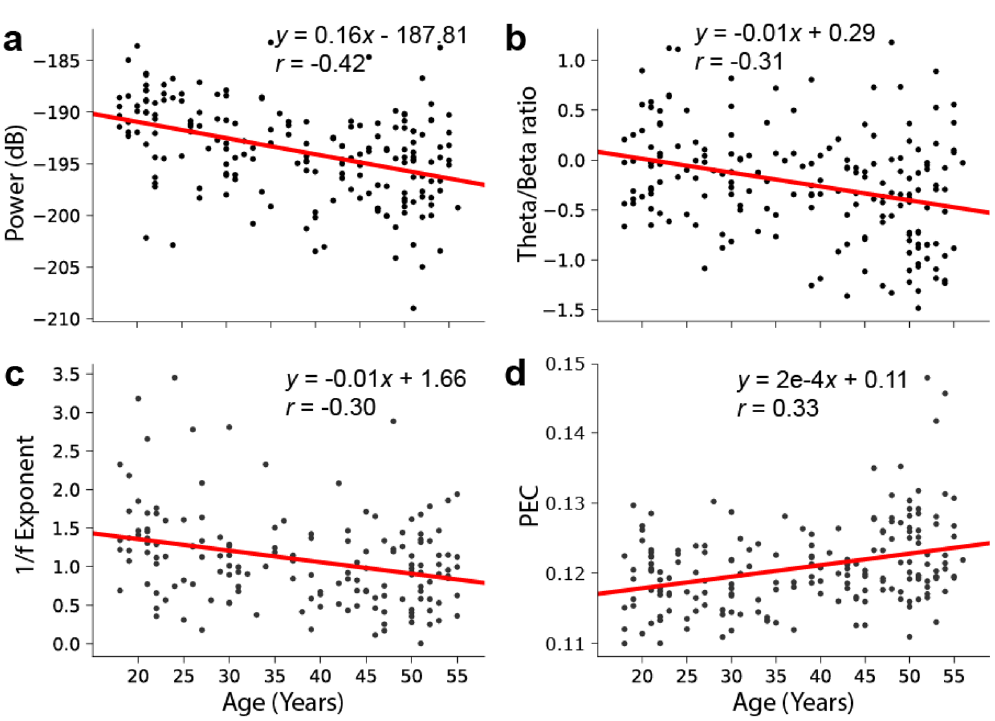
Figure 2. Several EEG features exhibit age dependence. Scatter plots illustrating correlations between age and ( a ) Absolute Power, ( b ) Theta/Beta Ratio, ( c ) 1/f exponent, and ( d ) PEC of source-modelled